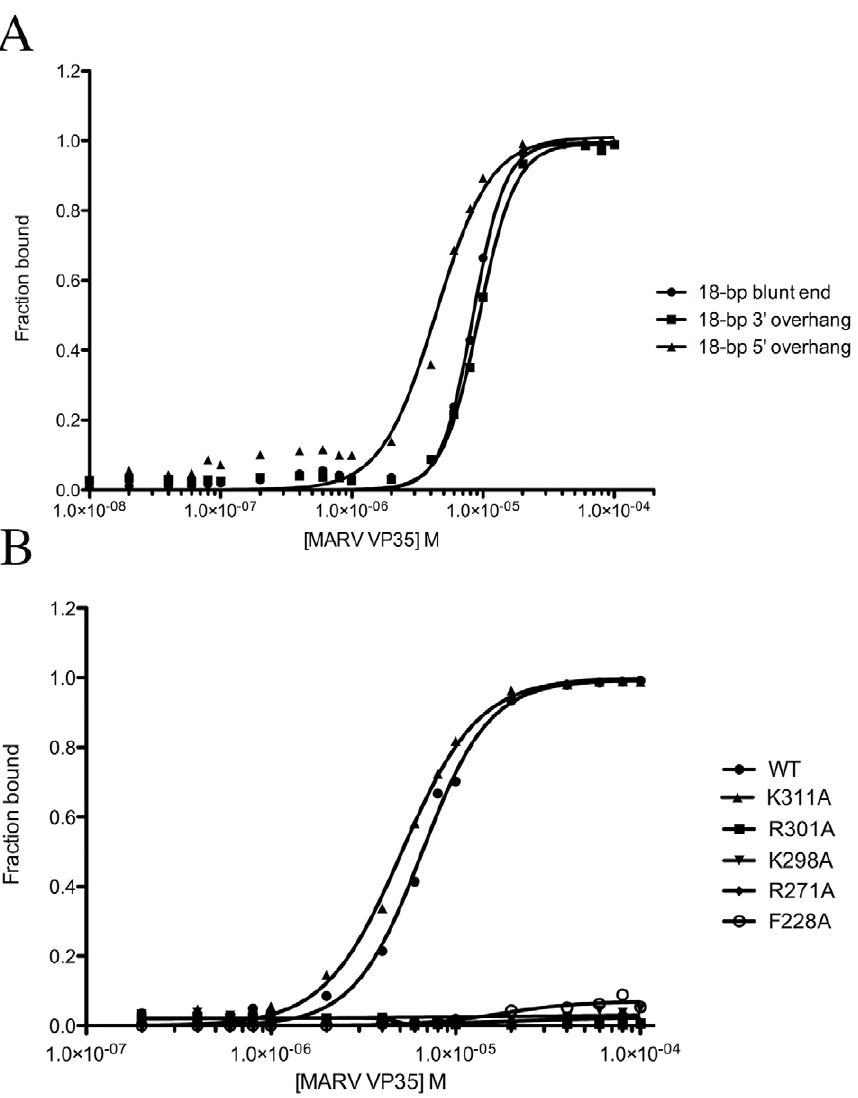
Figure 4. Binding of wild-type and mutant MARV VP35 RBD to dsRNA. (A) MARV VP35 binds with similar affinity to 18-bp dsRNA with blunt ends or with a 3 9 or 5 9 - overhang. (B) Binding of R301A, K311A, K298A, R271A, and F228 mutants of MARV VP35 RBD to 18-bp blunt ended dsRNA. Only the wild-type VP35 and the K311A mutant bind to dsRNA.